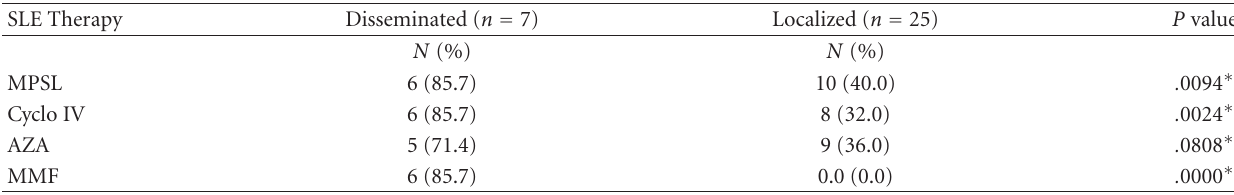
Table 3: Disseminated/Localized Zoster in relation to SLE